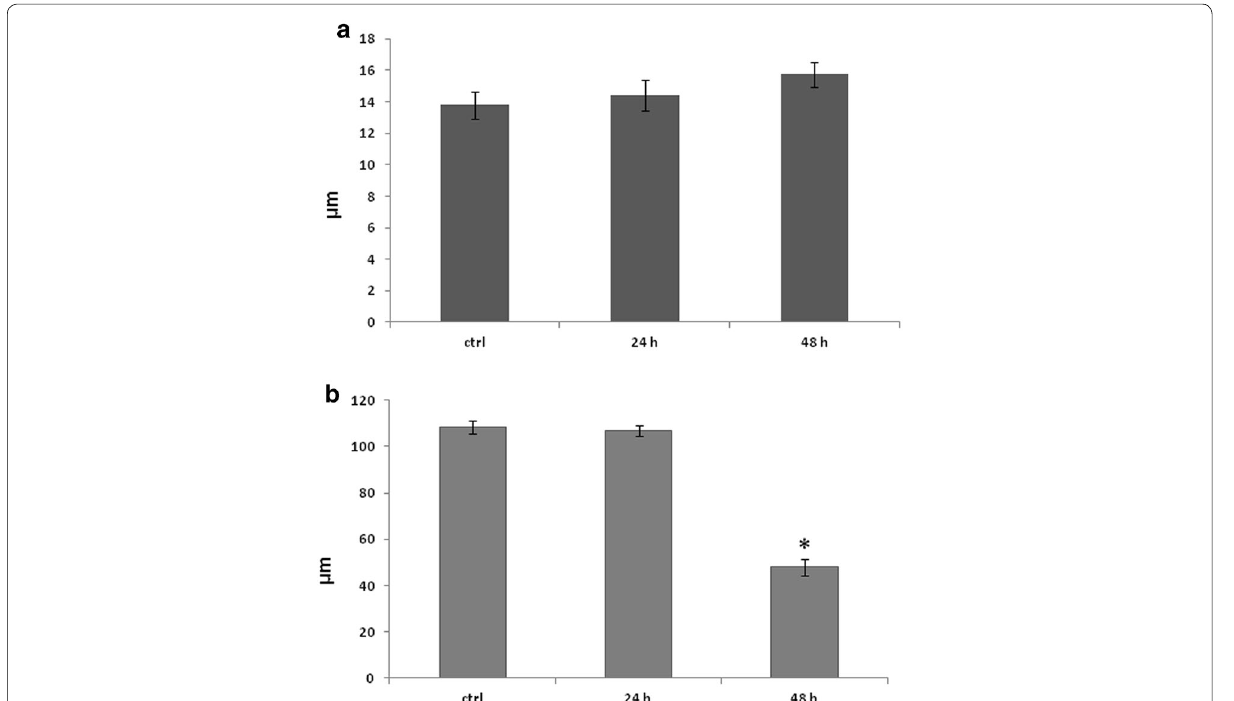
Fig. 2 Diagrams depicting the mean length (parallel to the root axis) of meristematic ( a ) and fast elongation ( b ) zone cells in untreated and aphidicolin‑treated roots. Error bars represent standard error of the means (n significant difference compared to the control ( p